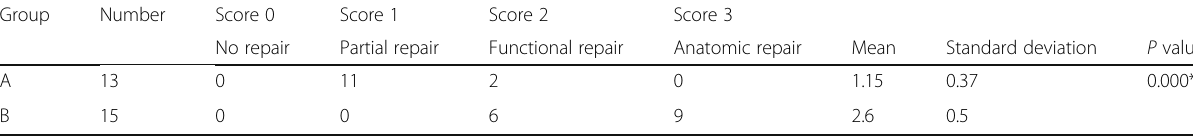
Table 2 Distribution of the teeth according to the level of repair seen and mean readings for level of repair Group